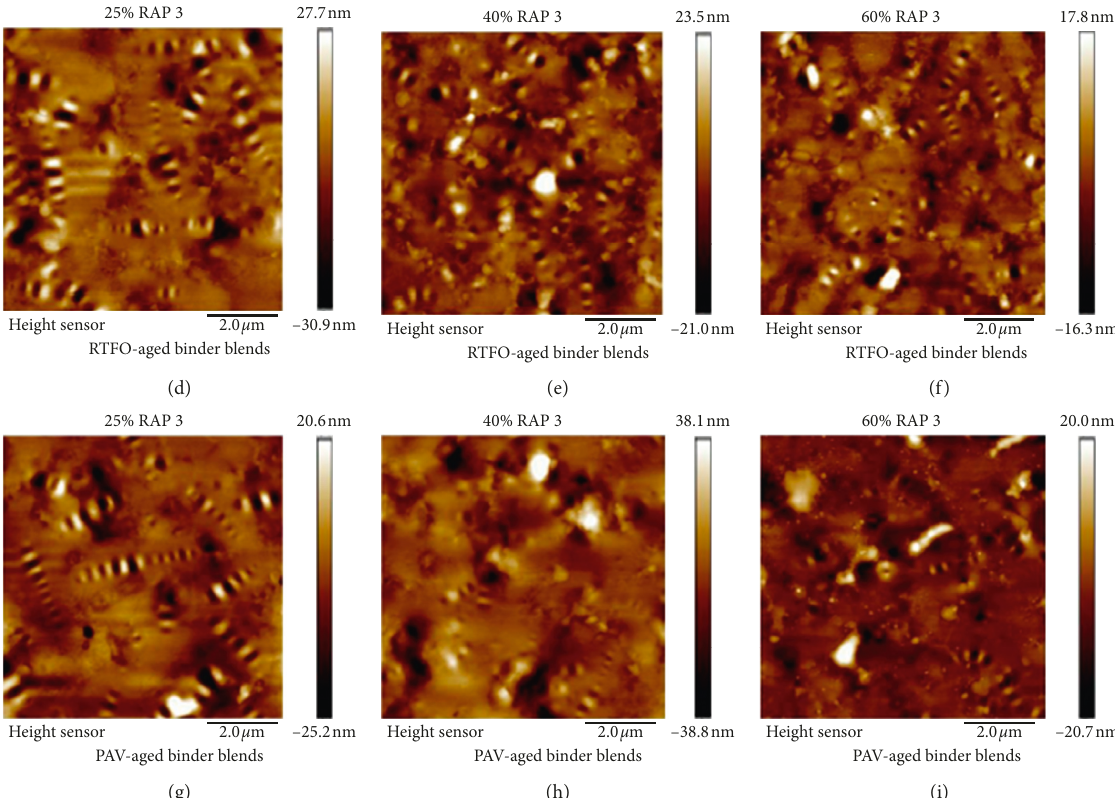
Figure 12: Morphology of RAP-asphalt blends: (a–c) 25%, 40%, and 60% unaged blends, (d–f) 25%, 40%, and 60% RTFO-aged blends, and (g–i) 25%, 40%, and 60% PAV-aged blends,